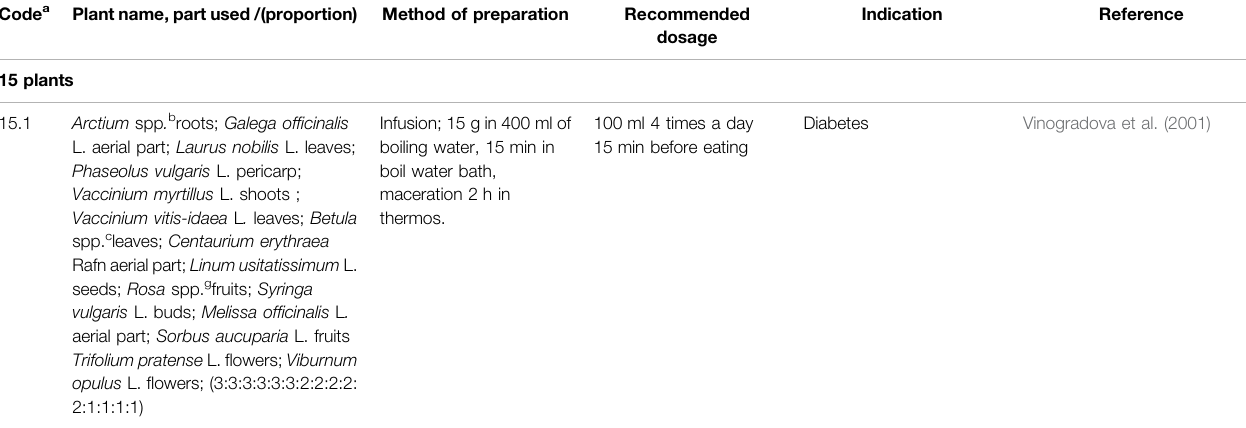
TABLE 1 | ( Continued ) The list of medical species used for the management of diabetes and related disorders in Russia. Code a Plant name, part used /(proportion) Method of preparation